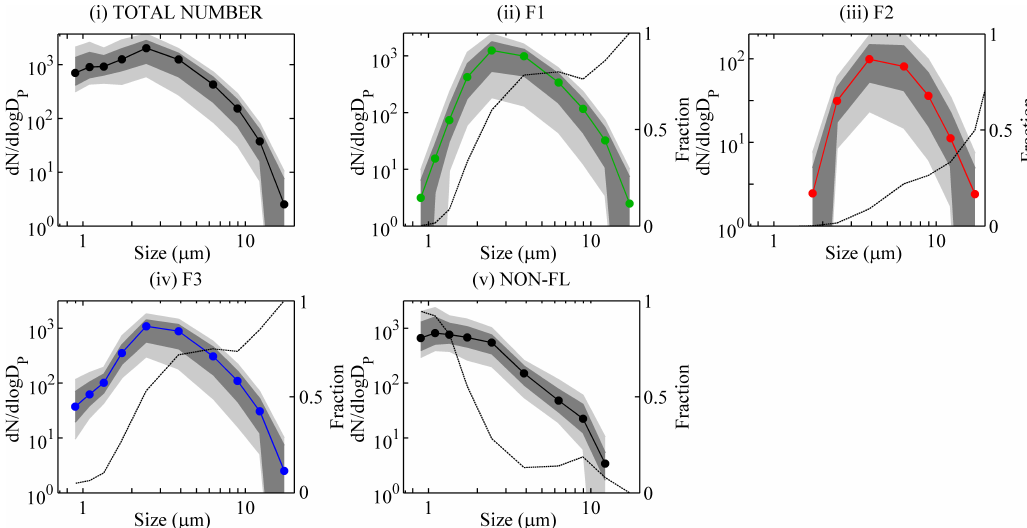
Fig. 7. Borneo number size distributions (logarithmic mid-size bins) for each particle type. Solid line: median, dark shading: inter-quartile range light shading: 10% and 90%. Dashed lines show median number fraction N / N TOT . Percentiles intersecting the x-axis represent a zero